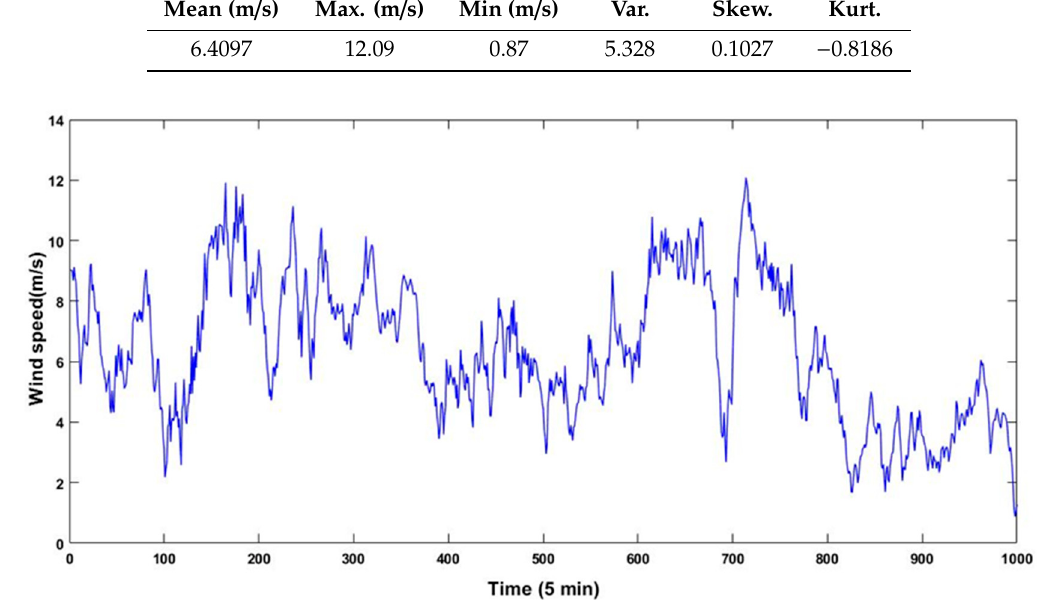
Figure 3. Original wind speed time series. Table 1. Statistics information of data.